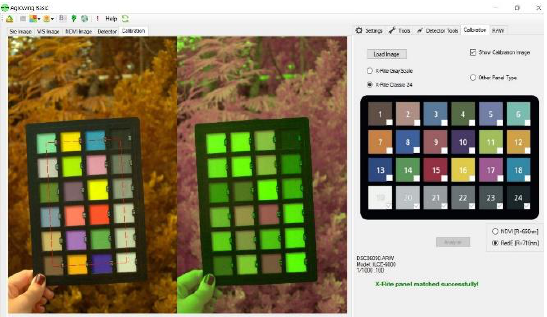
Figure 6 . A successfully matched with an X-rite Classic 24 panel rotated 90º